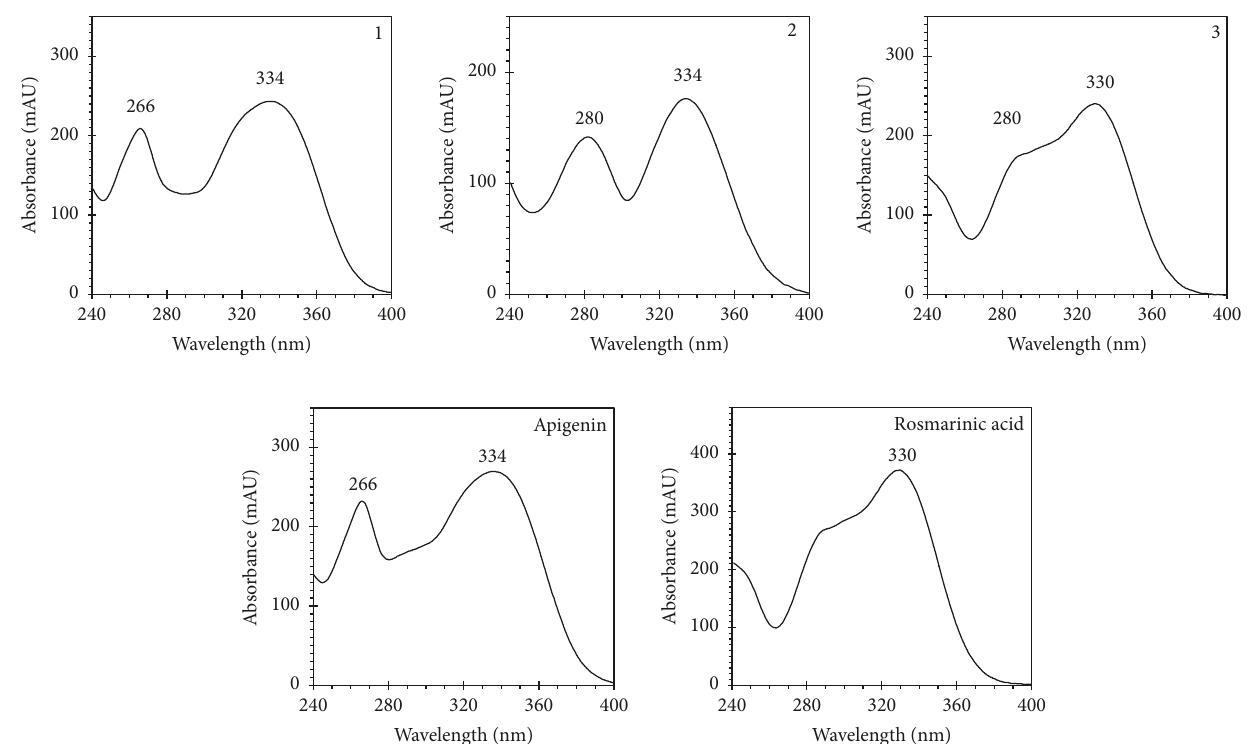
Figure 2: UV-DAD spectra of compounds 1–3 separated using